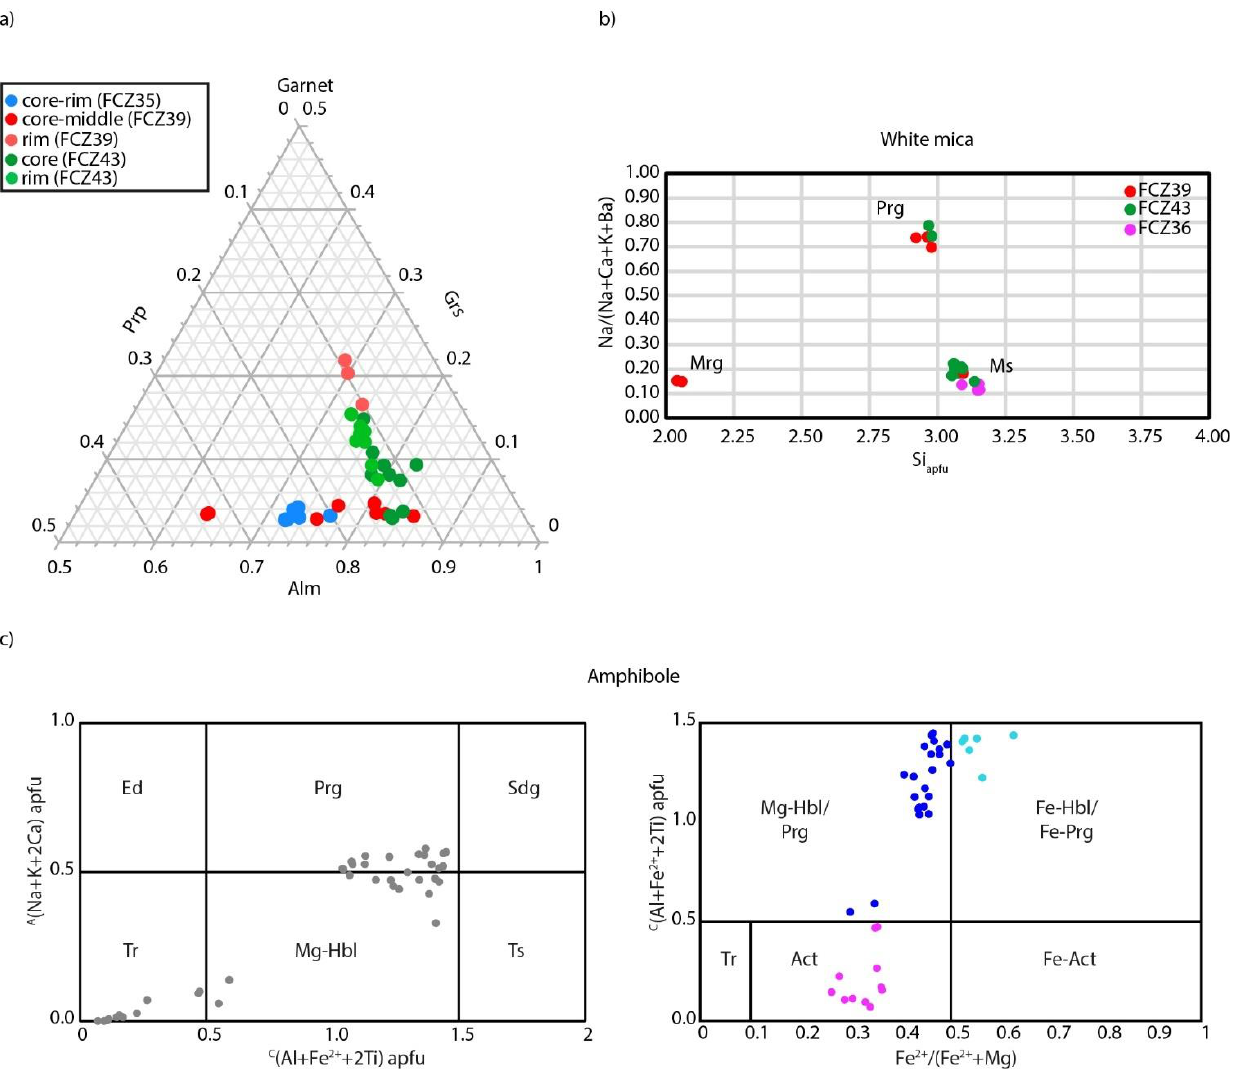
Figure 6. ( a ) Garnet Alm-Prp-Grs compositional triangle; note the overlapping between the compo- sition of garnet porphyroblast in Grt-Sil migmatitic paragneiss (sample FCZ35) and that of the relict cores of garnet in Grt-Ctd mylonitic schists (samples FCZ39, FCZ43). Note how the composition of garnet in Grt-Sil migmatitic paragneiss is homogeneous from core to rim and it is very similar to that of the relict cores and middle in Grt-Ctd mylonitic schists but strongly differs from that in the rim or in the new Grt grains, which are Ca-richer. ( b ) Si apfu vs. Na/(Na + Ca + K + Ba) diagram high- lighting the different composition of white micas in mylonitic samples. ( c ) Classification diagrams of Ca-amphiboles in metabasites. Left side: common compositional diagram with boundaries for Ca-amphiboles; projection is on Mg-pure endmembers, according to [40]. Right side: Ca-amphibole compositional diagram constructed by projecting from the A site: the composition of the amphibole in Opx-Cpx and Amph-bearing mafic granulite and the core pre-kinematic amphibole in mylonitic amphibolite is coloured in blue, that of the rim and deformation tail in mylonitic amphibolite is coloured in sky blue and that of the amphibole in the matrix of the mylonitic amphibolite is coloured in magenta.